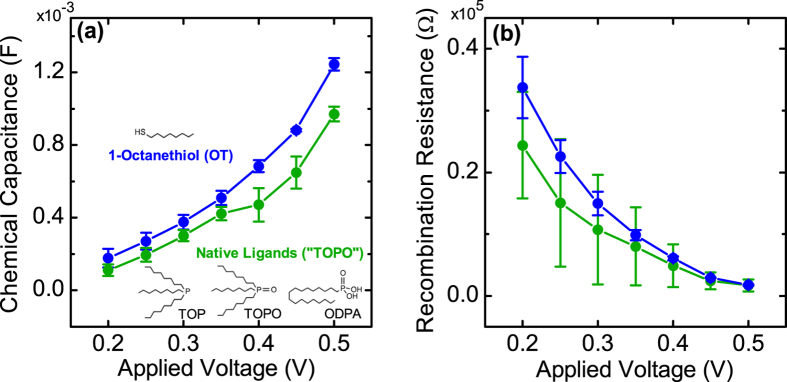
(a) Chemical capacitance (Cμ) and (b) recombination resistance (Rrec) of TiO2 photoelectrodes sensitized with CdSe/CdSe0.4Te0.6 HNRs having different passivation ligands, measured by electrochemical impedance spectroscopy (EIS) under dark conditions. Each point is the average value from two sets of samples prepared in parallel.